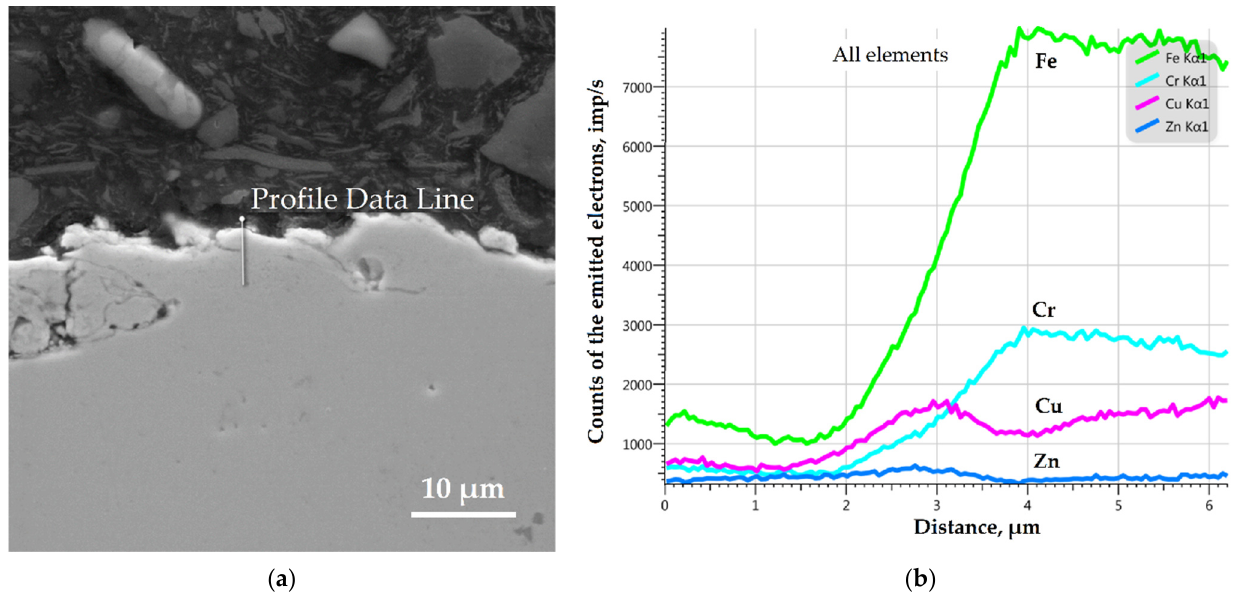
Figure 10. Nanomodification of X10CrNiTi18-10 (12kH18N10T) steel sample subsurface layers at cross-sectional area: ( a ) SEM in secondary electrons; ( b ) energy dispersive spectroscopy (elemental analysis) along the profile line.